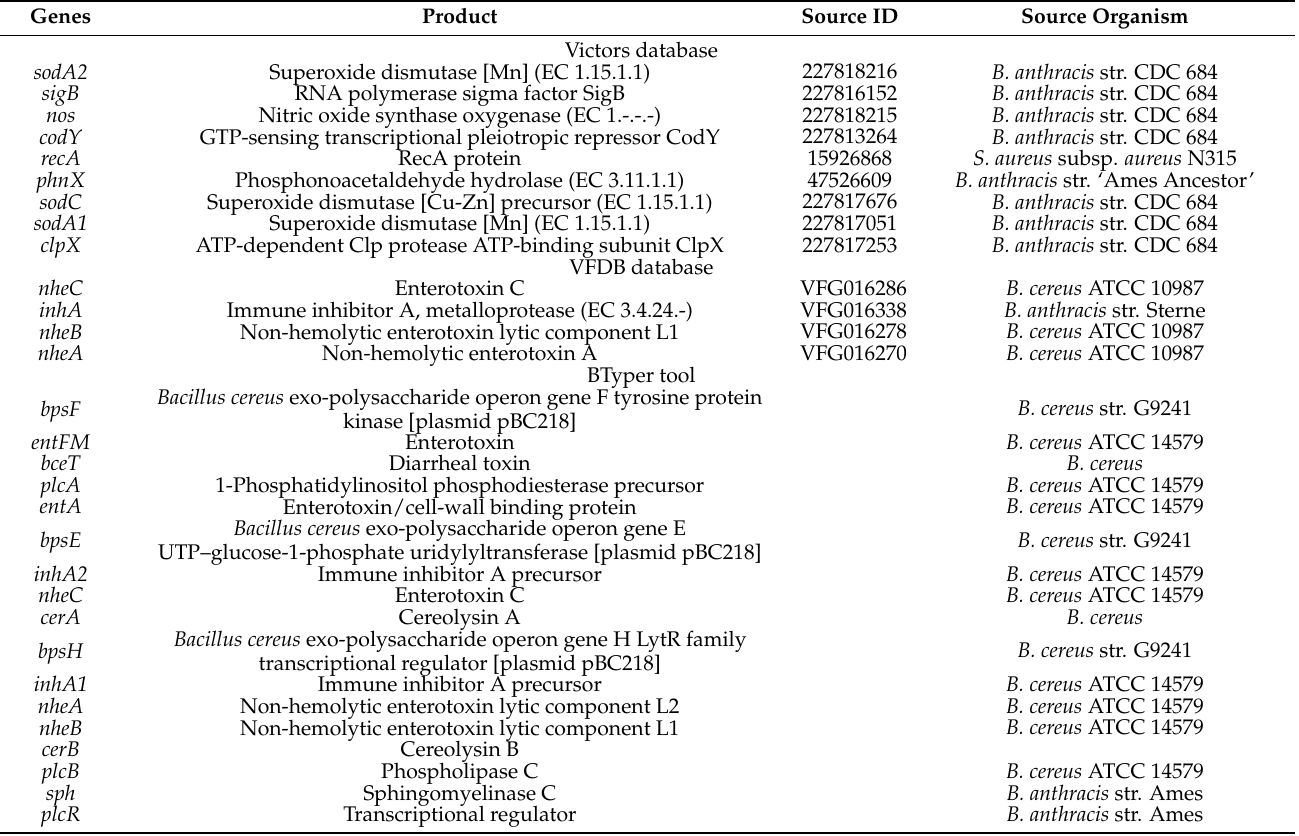
Table 6. Prediction of genes related to virulence factor of Bacillus sp. B87 according to Victors and VFDB databases, and BTyper